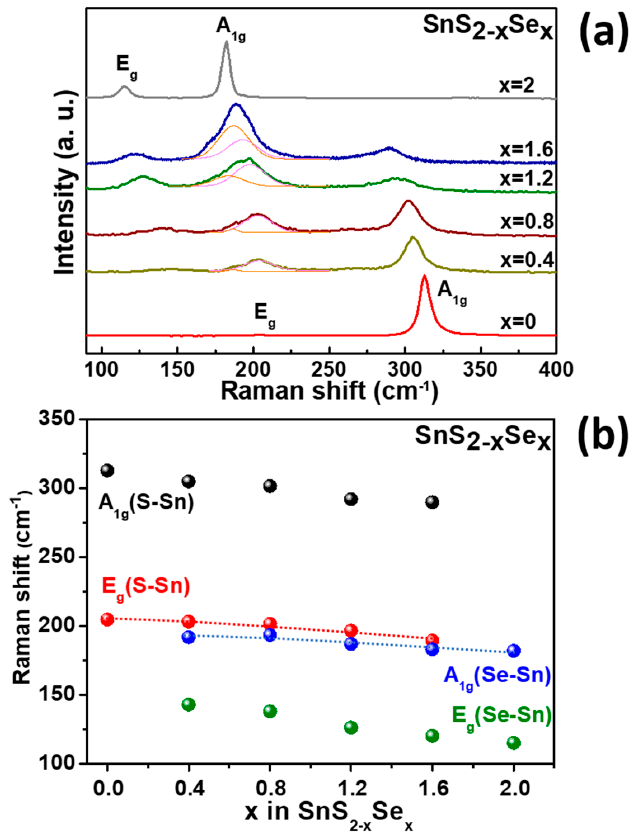
Figure 2. ( a ) Composition-dependent Raman spectra of SnS 2-x Se x layered crystals. The pink and orange curves correspond to the adjustments of the E g (S-Sn) and A g (Se-Sn) peaks, respectively. ( b ) Evolution of Raman peak positions of SnS 2-x Se x in the range of 100–400 cm − 1 . The dashed lines are guided by eyes.